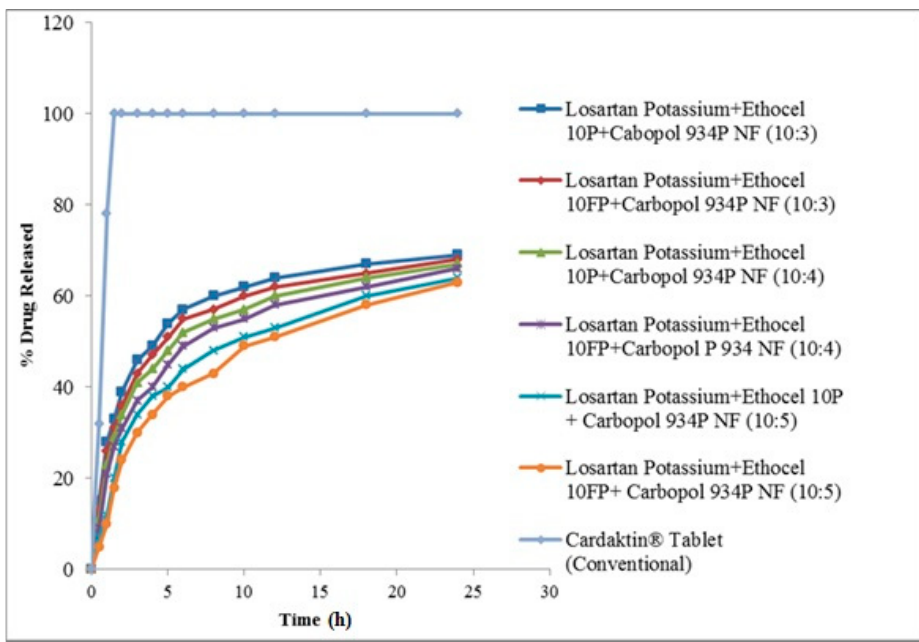
Figure 1. Drug release from polymeric matrices. The points in the curves indicate the mean value of three repetitions.